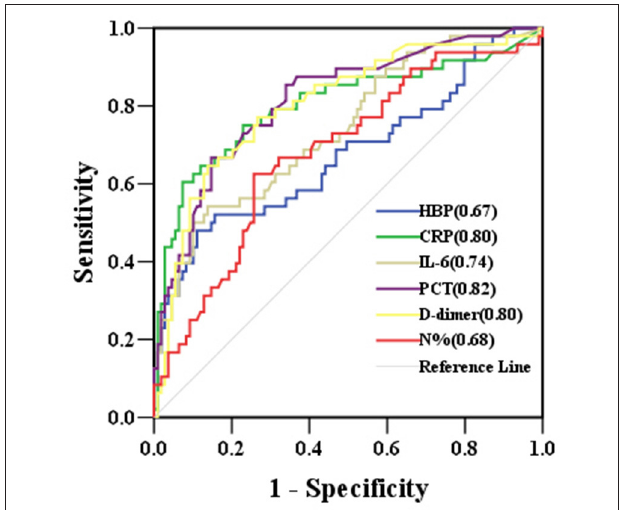
FIGURE 3 | ROC curves for biomarkers predicting the development of sepsis in children with severe community-acquired pneumonia. AUCs are indicated on the graph. AUC, area under the receiver operating characteristic curve; HBP, heparin-binding protein; CRP, C-reactive protein; IL-6, interleukin-6; PCT, procalcitonin; N%, neutrophil percentage; ROC, receiver operating characteristic.